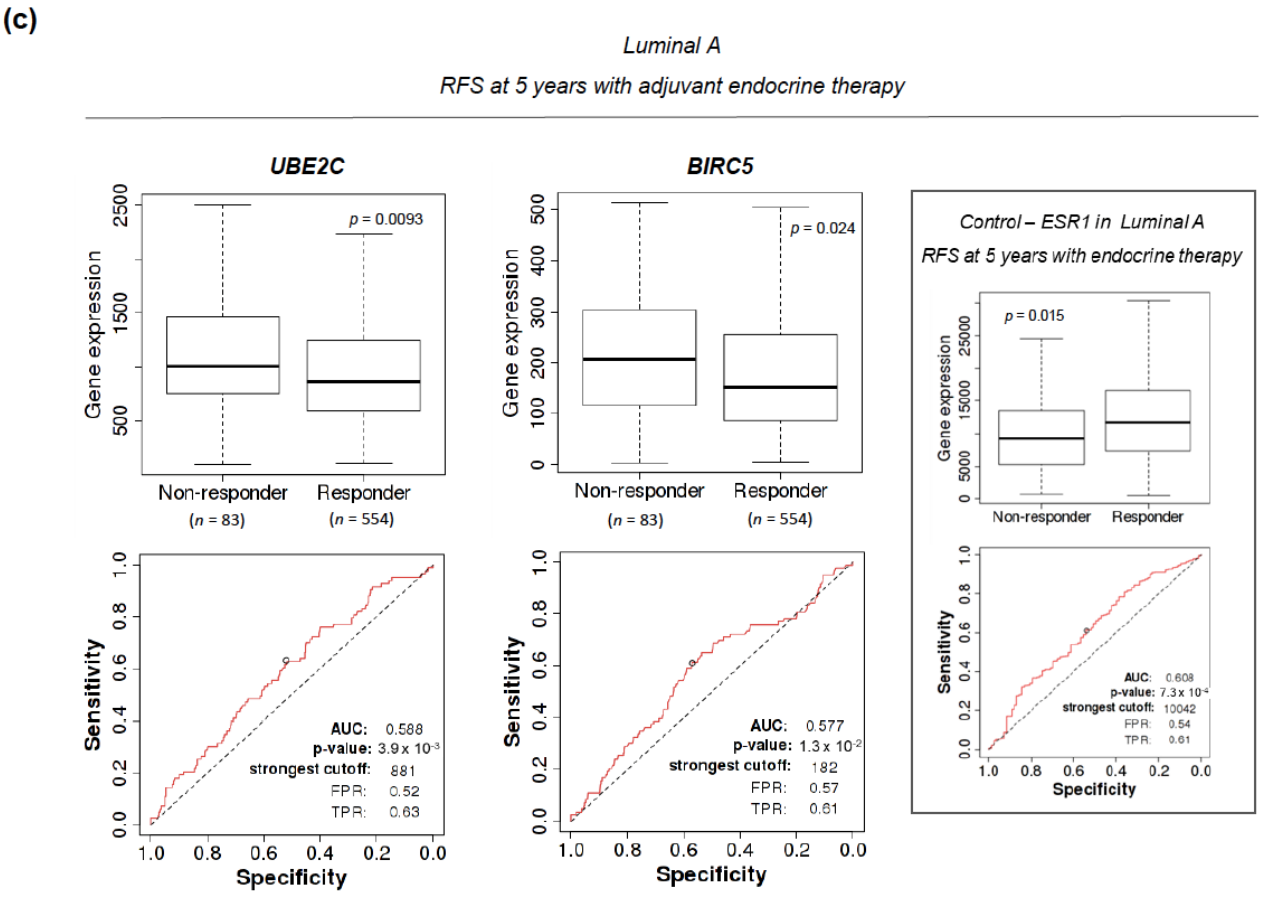
Figure 6. Association between gene expression and response to anti-tumor therapies. ( a ) Difference in gene expression of UBE2T in TNBC patients according to the achievement of a pathological complete response (pCR) after neoadjuvant therapy. ROC curve displaying the predictive capability of pCR of UBE2T . ( b ) Difference in gene expression of UBE2C and BIRC5 in luminal A patients according to the achievement of 5 years of RFS after adjuvant chemotherapy. ROC curve displaying the predictive capability of 5 years RFS of UBE2C and BIRC5 . ( c ) Difference in gene expression of UBE2C and BIRC5 in luminal A patients according to the achievement of 5 years of RFS with adjuvant endocrine therapy. ROC curve displaying the predictive capability of 5 years RFS of UBE2T and BIRC5. Companion graphs for ESR1 are included as control and help apprehend the potential clinical relevance of the predictive associations.